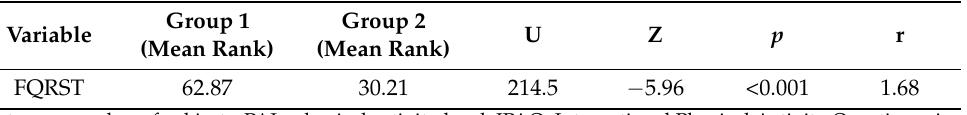
Table 2. Comparison of recorded parameters (Mann Whitney test) between group 1 ( n = 35, with low PAL) and group 2 ( n = 51, with moderate PAL), grouping variable IPAQ category.